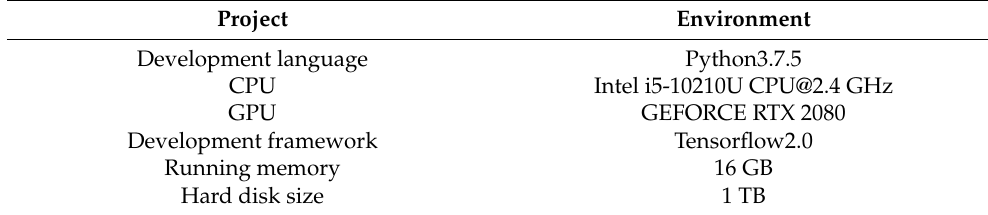
Table 1. Experimental